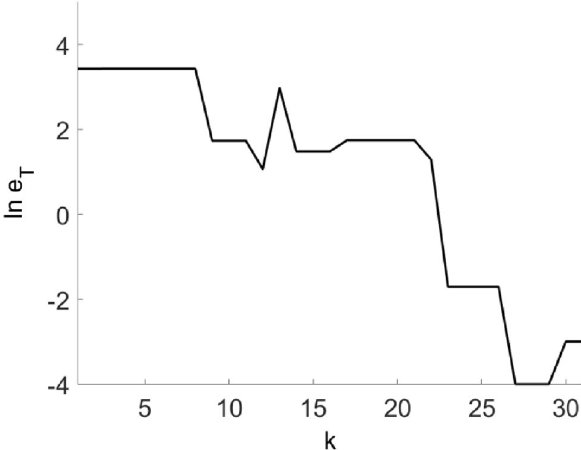
Figure 4. The parameter error e T changes with the iteration number k .